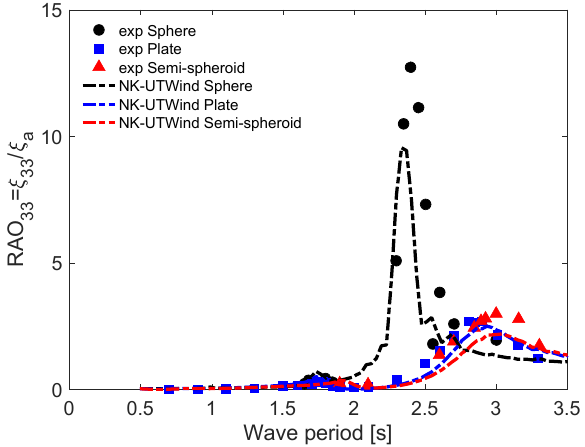
Figure 15. Response amplitude operator (RAO) heave motion comparisons between the experiment and NK ‐ UTWind numerical calculations for medium wave height and different heave plate configurations.